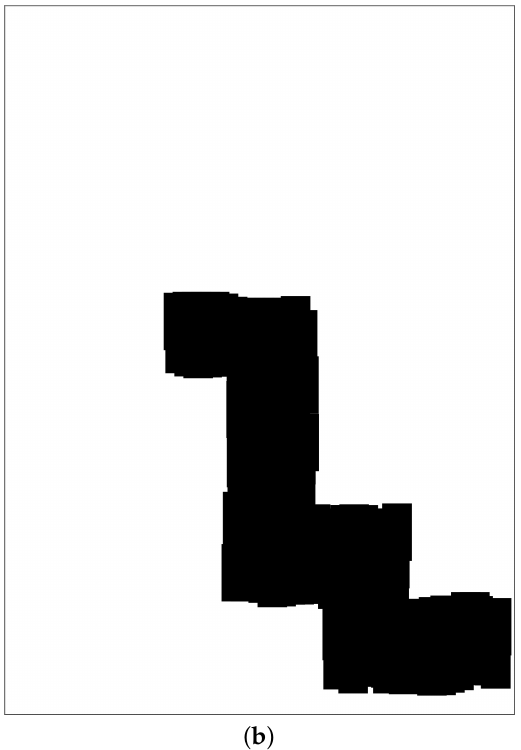
Figure 5. Example of a traversed path by the UAV and its corresponding footprint map. ( a ) Traversed path of the UAV (orange splines) in a simulated environment. The arrows indicate actions taken by the UAV per time step. Environment obstacles are depicted with blue and green blocks, and the believed victim location points are shown using a red point cloud. ( b ) Accumulated traced footprint using the extent of the camera’s FOV. Explored areas are depicted in black and unexplored areas in white. The higher the overlap of explored areas after taking an action a ∈ A , the higher the footprint overlap